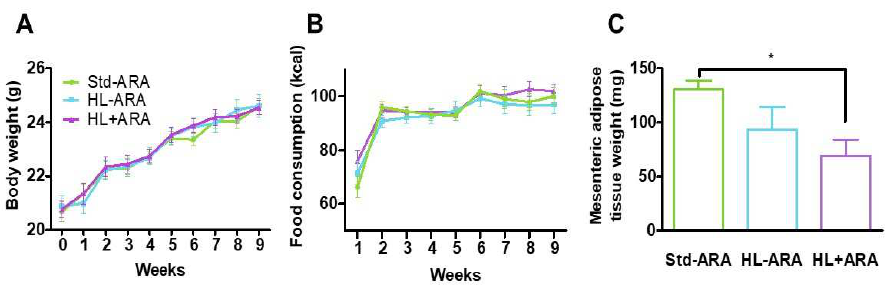
Figure 1. Kinetics of animal body weight ( A ) and food consumption ( B ) in male BALB/C mice fed on standard diet (Std-ARA) or lipid-rich diets without arachidonic acid (HL-ARA) or with (HL + ARA) for 9 weeks. Mesenteric adipose tissue weight ( C ) at the end of the study. Data are represented as the mean ± standard error of the mean (SEM). n = 15 per diet group for body weight and food consumption and n = 5 for mesenteric adipose tissue weight. * p < 0.05 compared with the standard diet, data analyzed by one-way ANOVA test and Bonferroni’s multiple comparisons test for post hoc analysis.